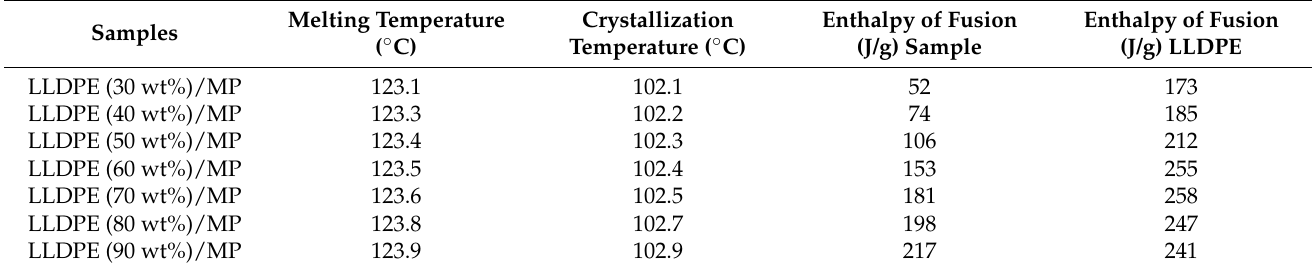
Figure 6. ( a ) Crystallisation ( ∆ H c , enthalpy of crystallization, is the area under the exotherm curve) and ( b ) melting ( ∆ Hm, enthalpy of fusion, is the area under the endotherm curve) of LLDPE/mesophase pitch blends. Table 3. Melting and crystallisation temperatures of LLDPE/mesophase pitch blends.